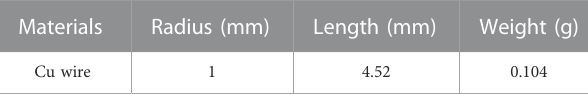
TABLE 4 Cu wire dimensions used for experimental validation of gel + Cu wire system (Sharma et al.,